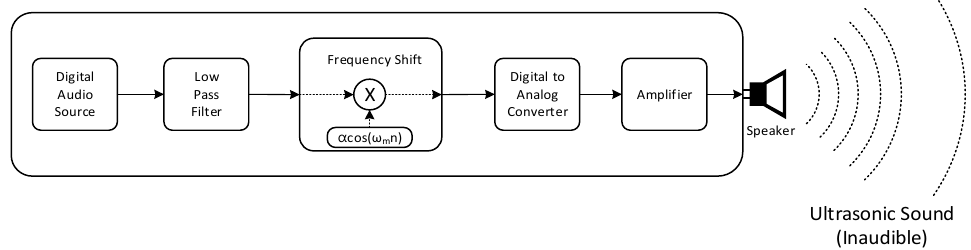
Figure 4. Simplified schematic block diagram of the